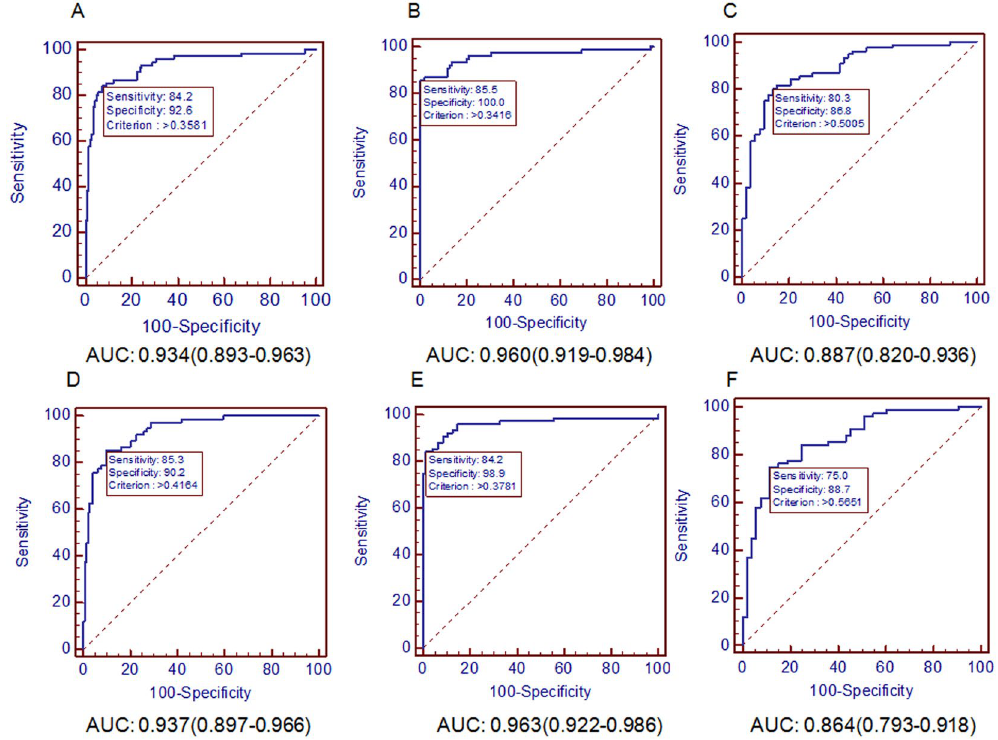
Figure 2. ROC analysis for HCC diagnosis in the training set. AUC of 5-variable panel for predicting HCC in ( A ) HCC versus non-cancer control in the training set, ( B ) HCC versus healthy in the training set, ( C ) HCC versus CHB in the training set. AUC of 3-variable panel for predicting HCC in ( D ) HCC versus non-cancer control in the training set, ( E ) HCC versus healthy in the training set, ( F ) HCC versus CHB in the training